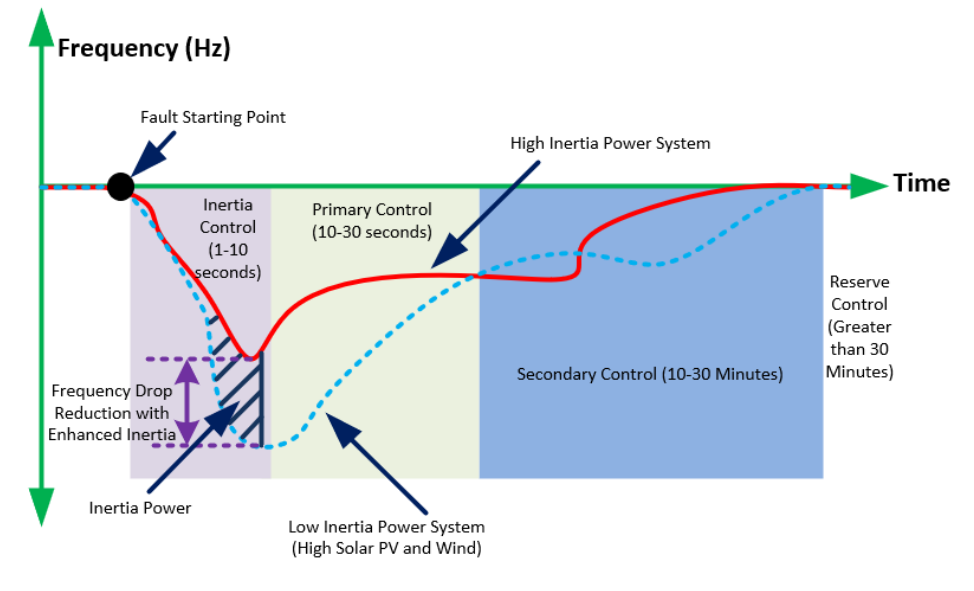
Figure 2. Post fault frequency response stages in power